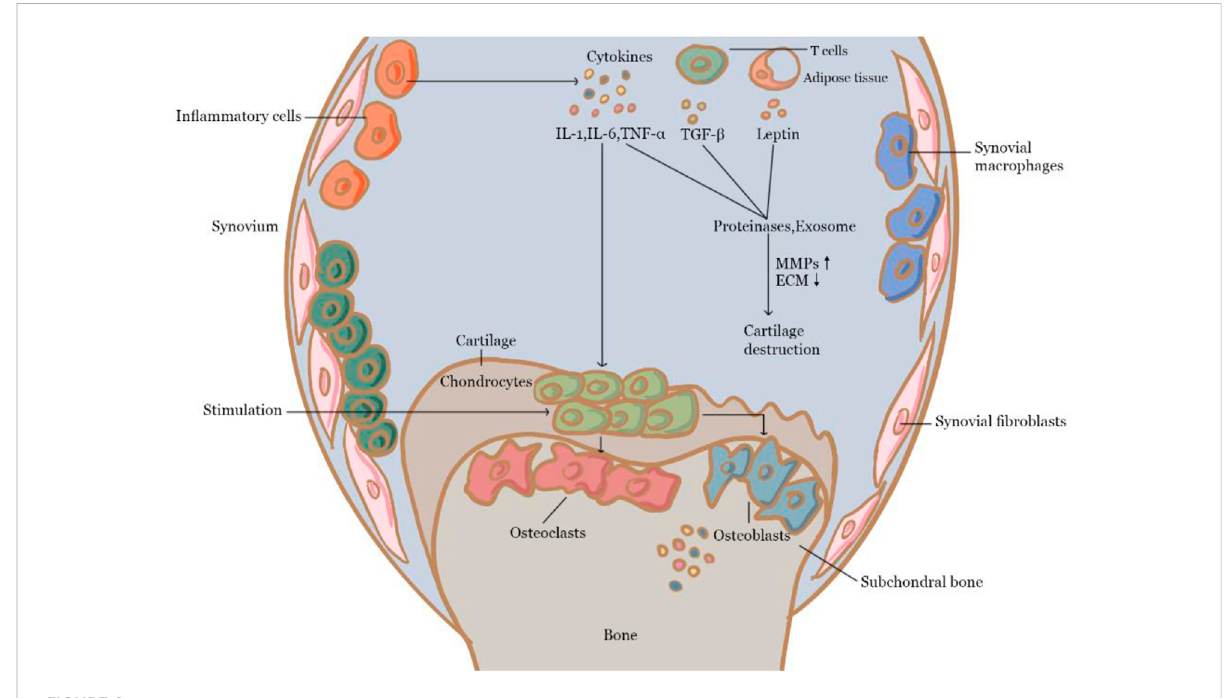
FIGURE 2 Cytokines and mechanism of